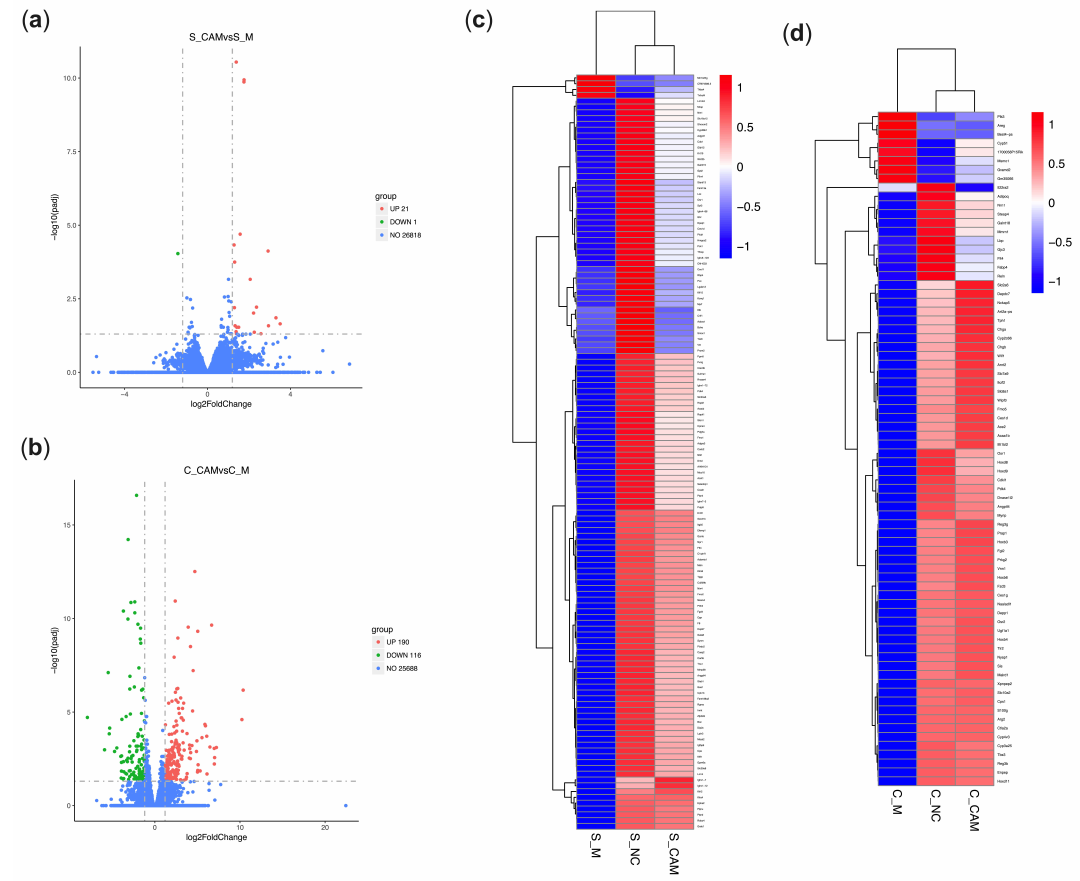
Figure 5. The influence of CA on splenic gene expression in PD mice based on RNA-Seq. ( a ) Volcano plot of splenic DEGs between the MPTP and CA+MPTP groups. ( b ) Volcano plot of colonic DEGs between the MPTP and CA+MPTP groups. The heatmaps showing the results of cluster analysis for DGEs between the control, MPTP and CA+MPTP groups in the spleen ( c ) and colon ( d ). CA pretreatment significantly restored the gene expression in the colon and spleen of MPTP mice; combining with the regulation of CA on IL-17, IFN- γ and TGF- β in PD mice, it was indicated that the neuroprotective effects of CA were closely related to the modulation of CA on peripheral immune system. Cut-off value of (|log 2 FC|) > 1.2 and padj < 0.05, n = 3 per group. S: spleen, C: colon. CAM: CA+MPTP group, M: MPTP group, NC: control